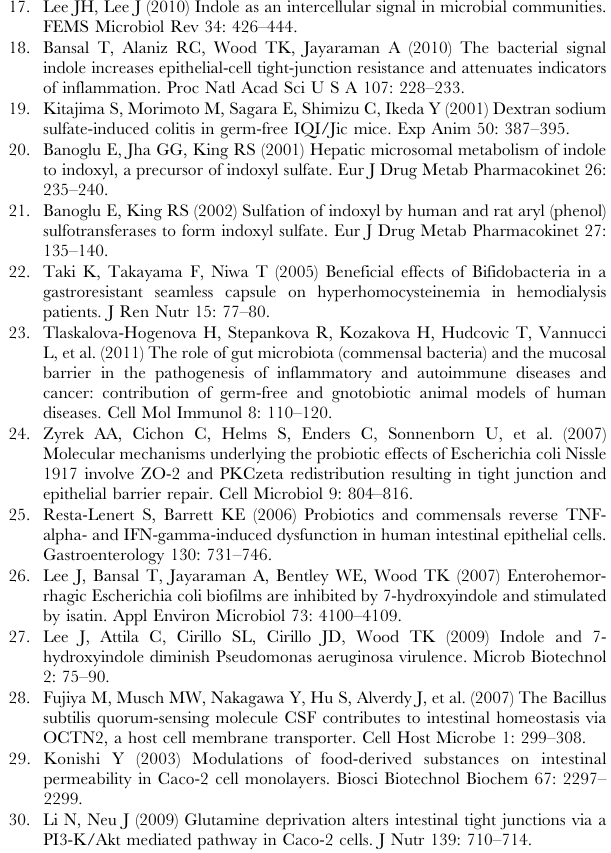
Figure S2 Carbon-containing seamless capsules dissolve at the end portion of small intestines after the administration by oral route. To confirm the delivery system of seamless capsules at the end portion of small intestines, mice were given carbon-containing